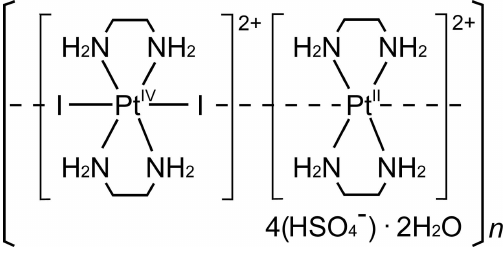
Table 1 Selected geometric parameters (A˚ , (cid:5) ).